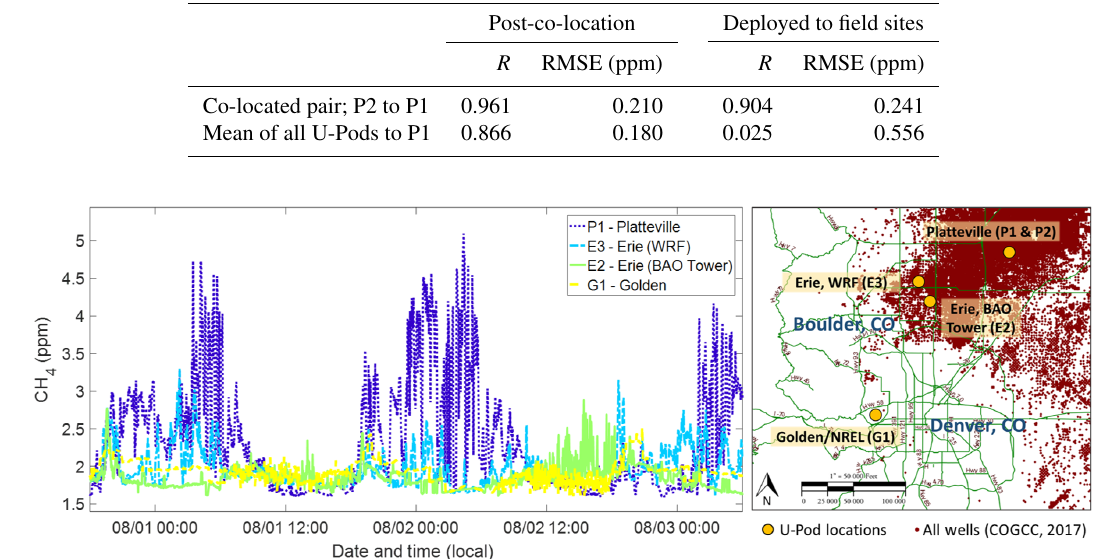
Figure 15. Time series of minute-resolution data from four Colorado sites and a map showing the location of the four U-Pod with respect to all active and inactive wells (COGCC, 2017).